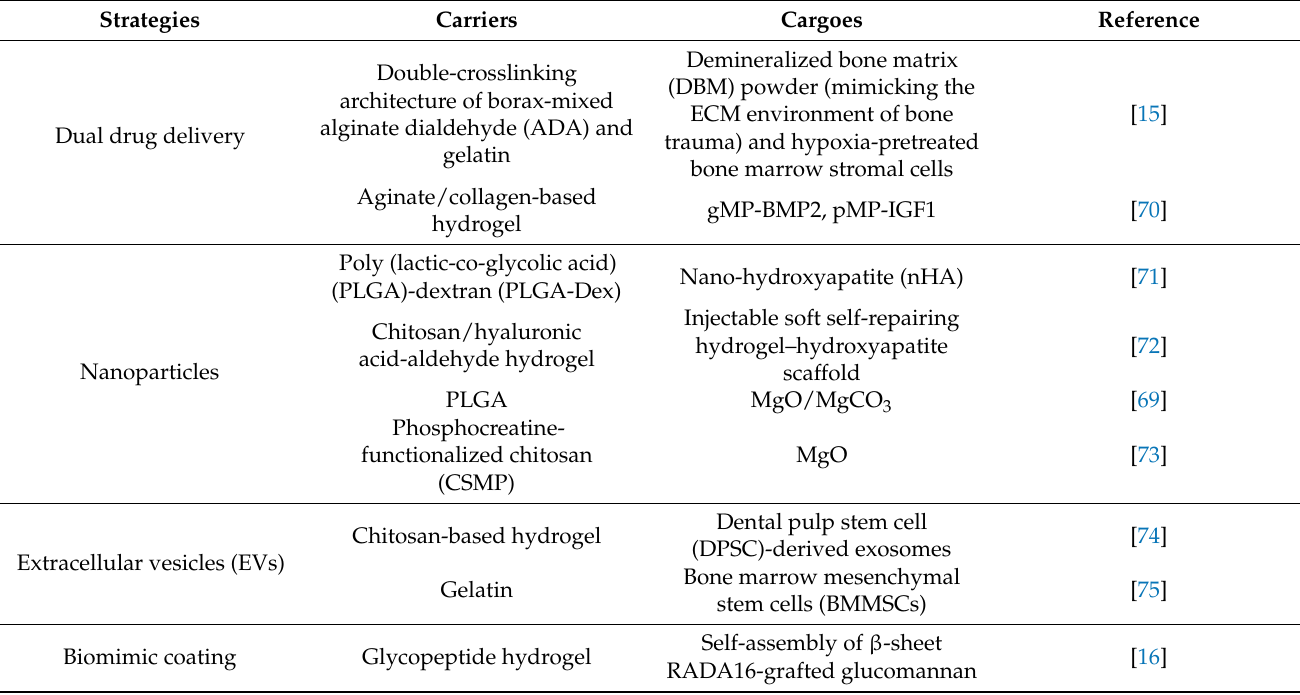
Table 1. Summary of the different strategies for carrying cargoes to enhance the cure